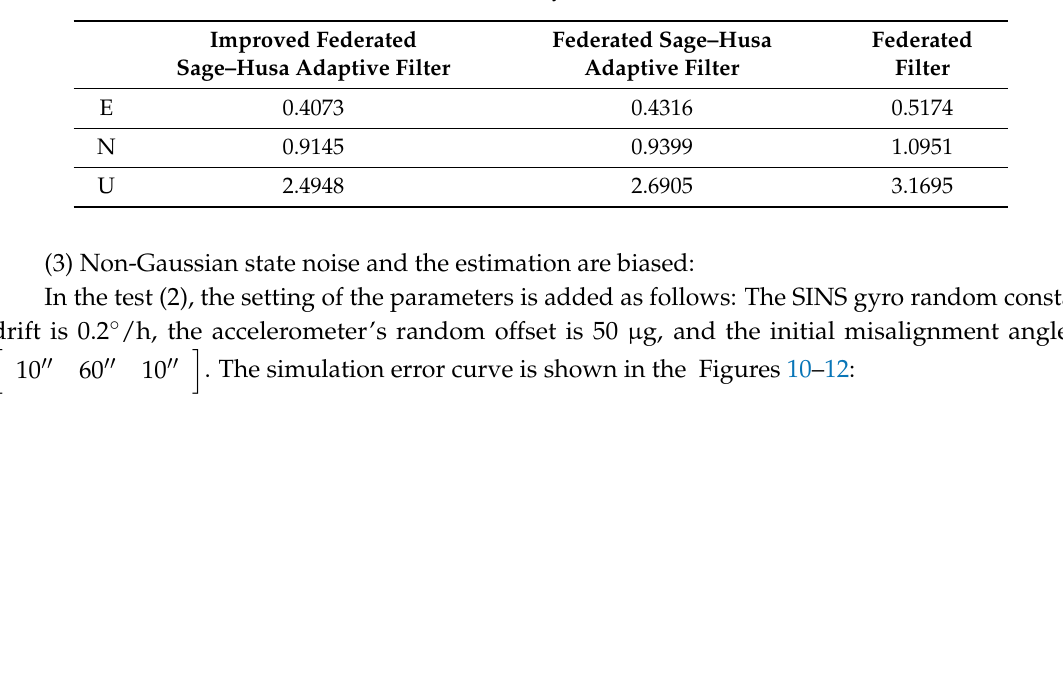
Table 4. Velocity error